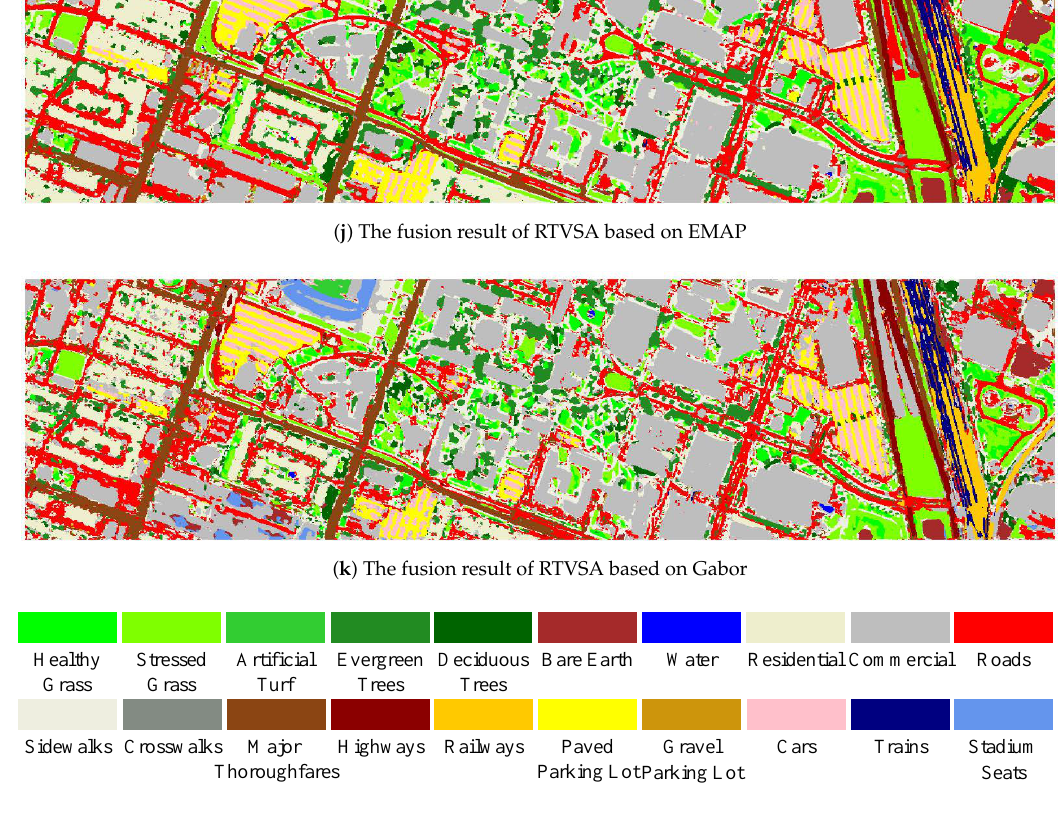
Figure 7. Classification maps obtained by CNN classifiers combined with the proposed methods on the 2017 Houston